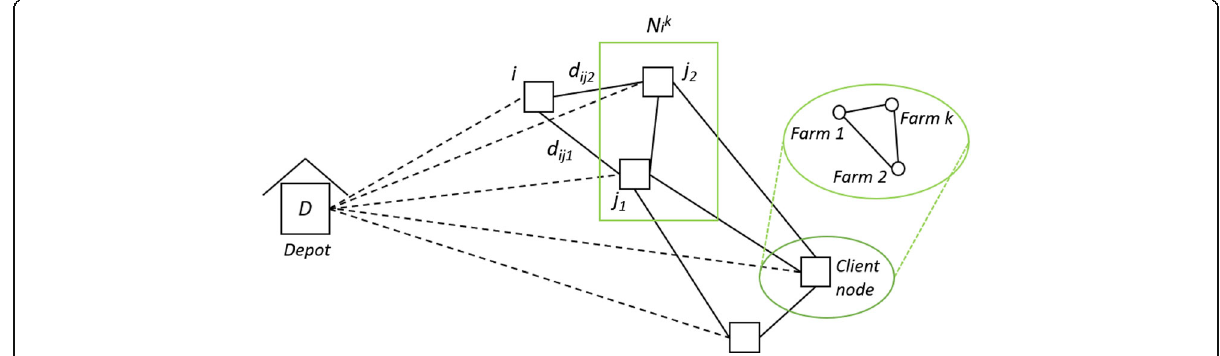
Fig. 1 “ Conceptual ” schematization of the depot, client nodes and possible